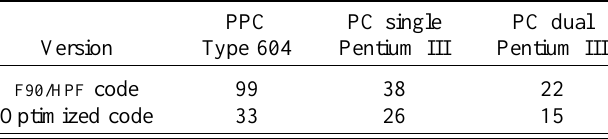
TABLE I. CPU time in seconds for the reconstruction without space charge of one well-resolved image using different proces-